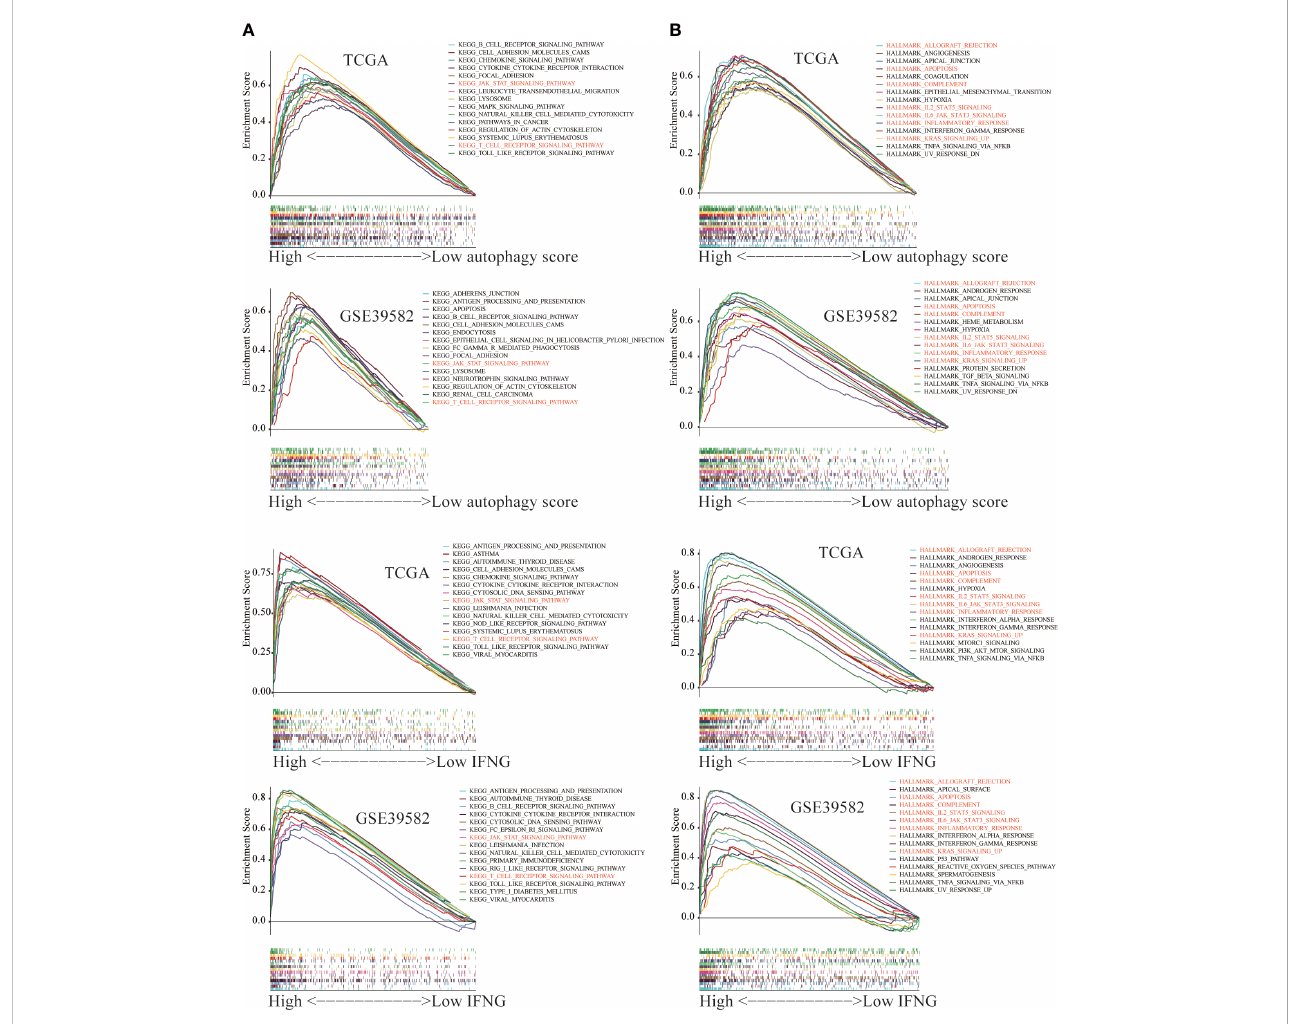
FIGURE 13 The Gene Set Enrichment Analysis (GSEA) between the high and low group of autophagy score and IFNG expression. The signi fi cant GSEA results shared by (A) TCGA and (B) GSE39582 were marked in